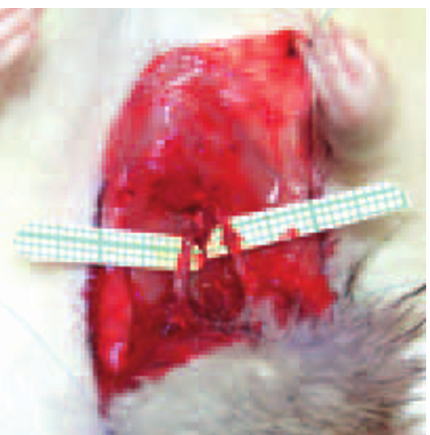
Figure 8. Jugular vein and common carotid artery anastomoses completed